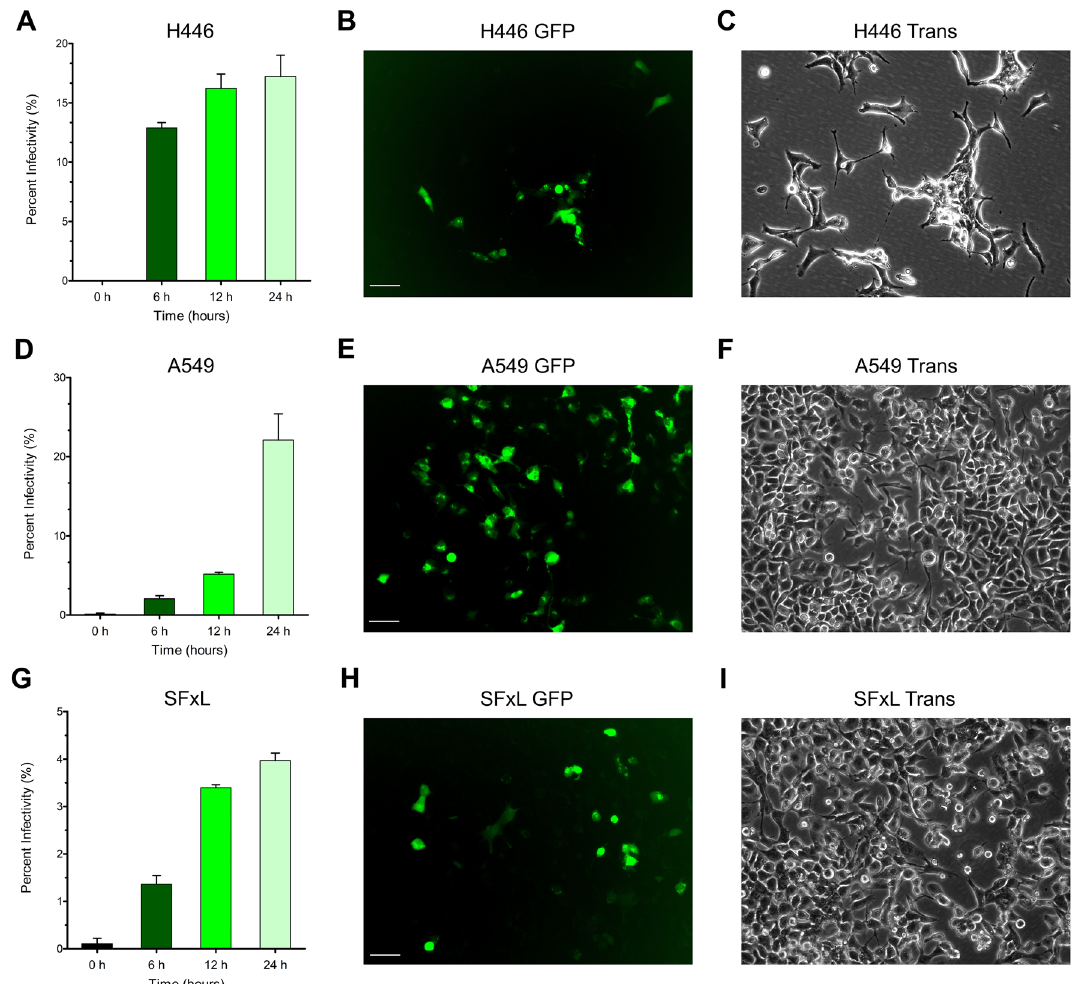
Figure 7. Time course assessment of myxoma virus infectivity: Percent infectivity reported over a 24 h period for all three cell lines (H446, A549, SFxL: N = 3). The percent of infected cells was determined by quantitating GFP signal captured with fluorescence microscopy. Representative images of FITC (GFP) and Transfluorescent (Trans) channels at 24 h are presented. The scale bar represents 50